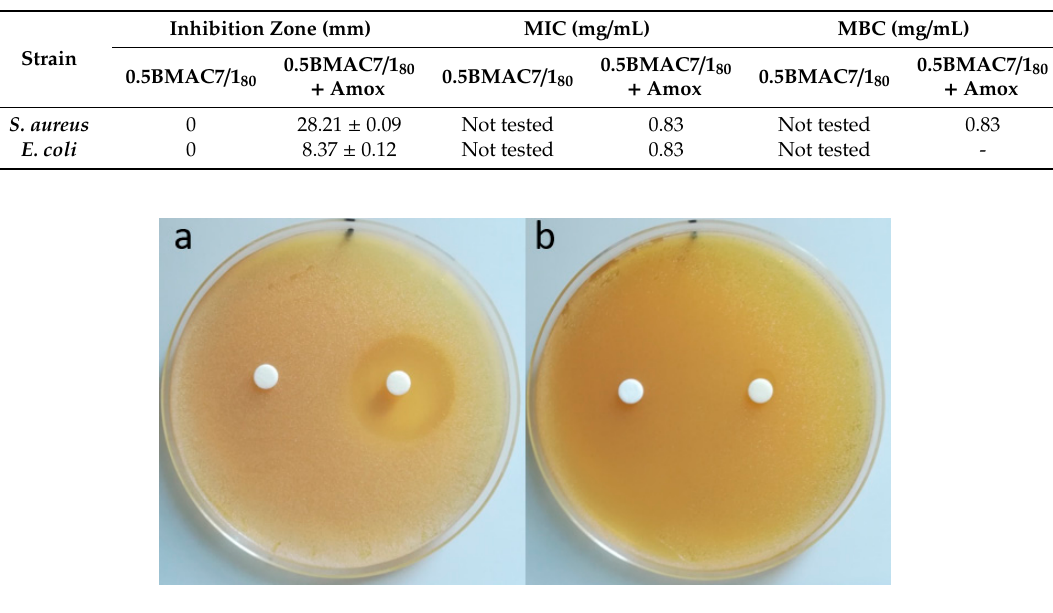
Figure 11. Antibacterial activity of nanogels 0.5BMAC7/1 80 (left) without Amox and 0.5BMAC7/1 80 with Amox (right) against S. aureus ( a ) and E. coli ( b ).